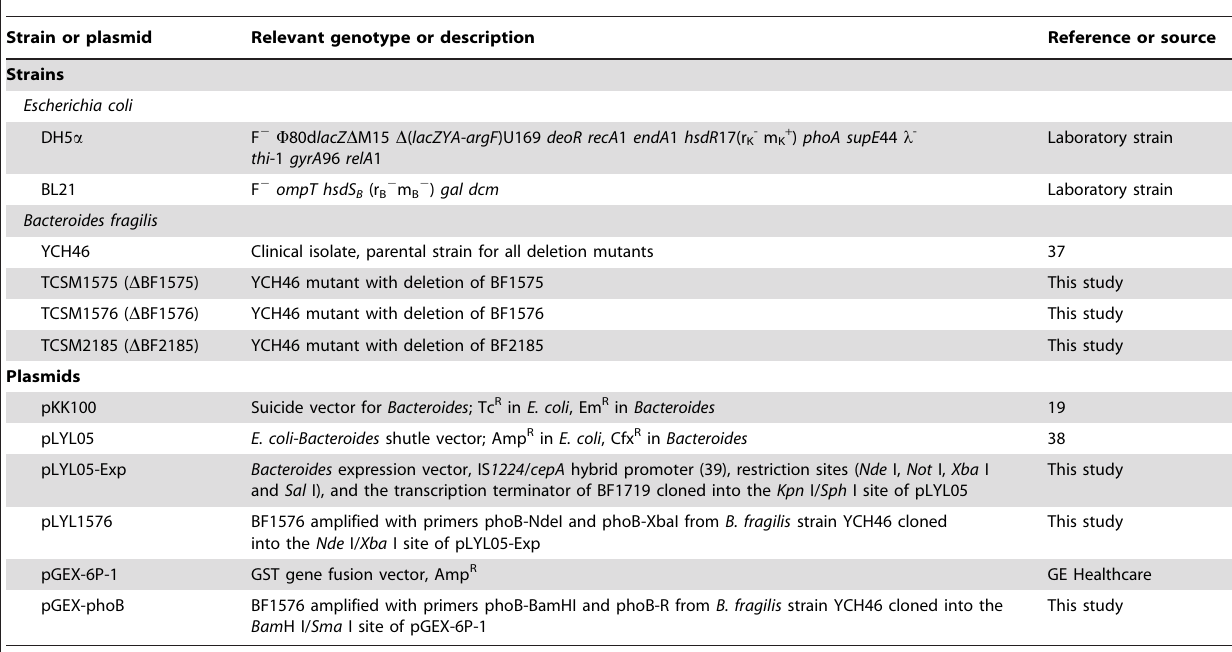
Table 1. Bacterial strains and